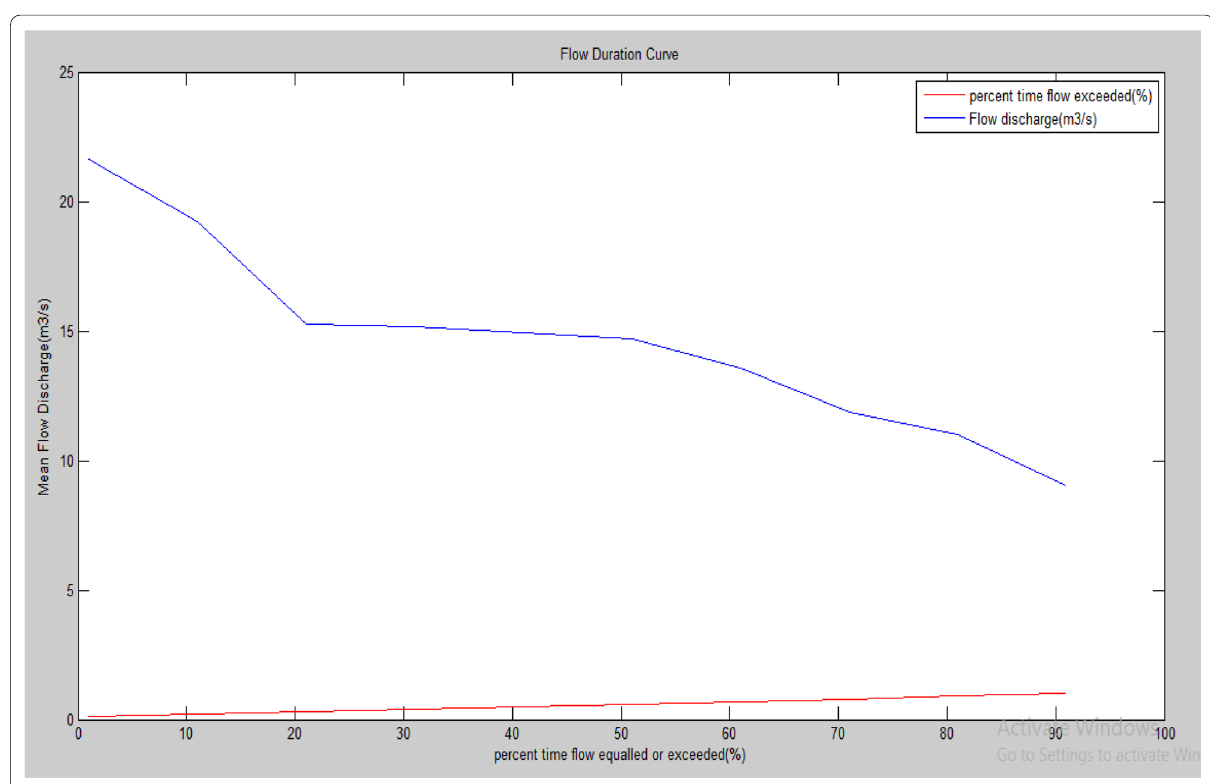
Fig. 5 Flow duration curve for the Ribb River (Karakoyun et al.